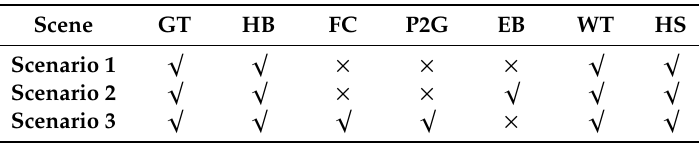
Table 2. Scenario classification.